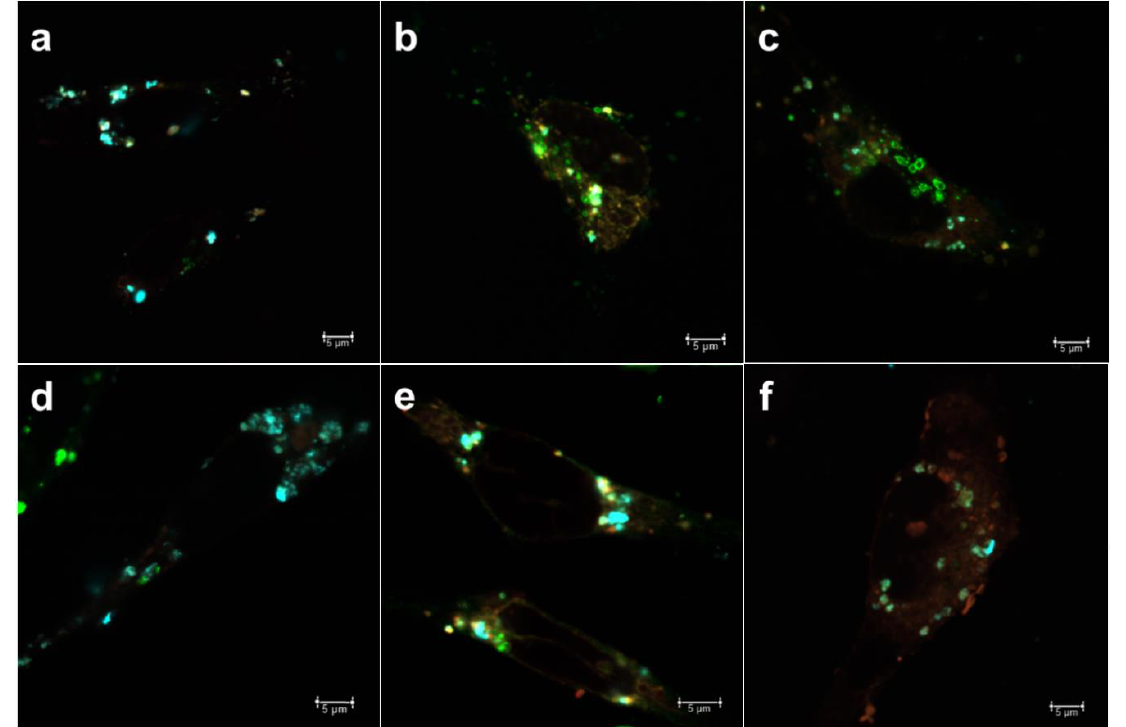
Figure 3. MSNs (cyan) loaded with fluorescent dye (DiD) (red) and endosomal markers (green) ( a – c ) early endosomal antigen-1 (EEA1) (0.1, 0.5, 1.0 wt % loading of DiD, respectively) and ( d – f ) Rab7 (0.1, 0.5, 1.0 wt % loading of DiD, respectively) at 24 h.